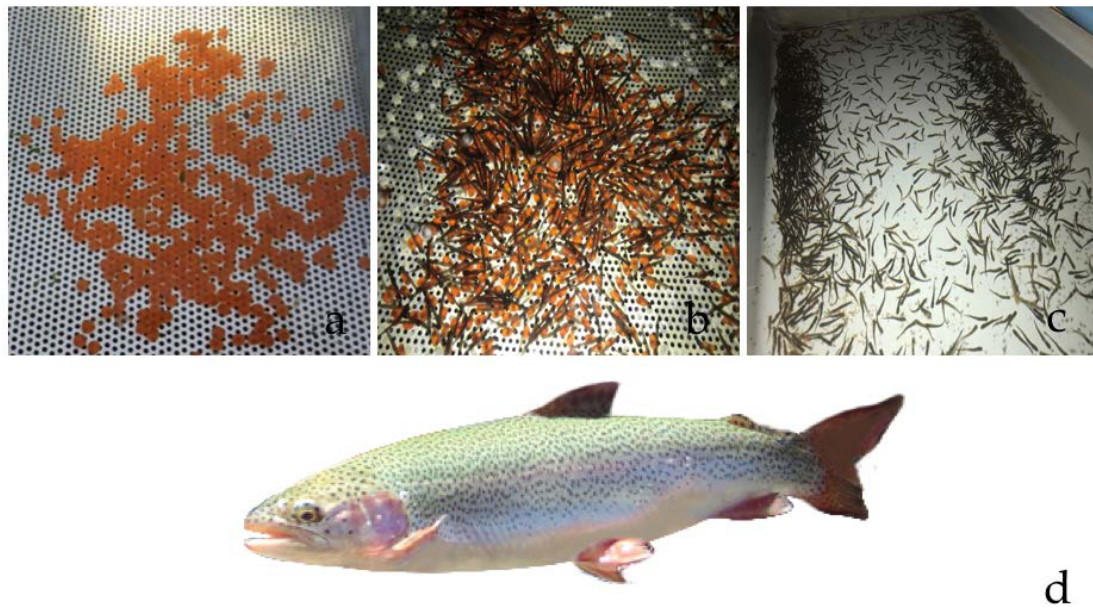
Figure 3. ( a ) Eggs, ( b ) larvae, ( c ) juveniles of Oncorhynchus mykiss, and ( d ) adult specimen, (photographs: own source) .